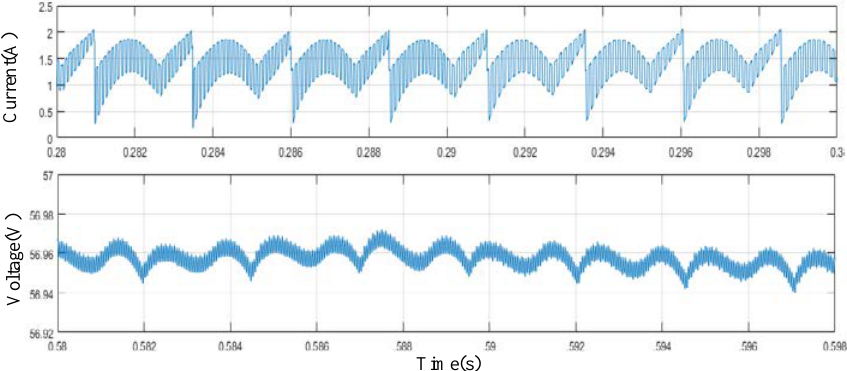
Figure 16. Current and voltage of DC-bus.